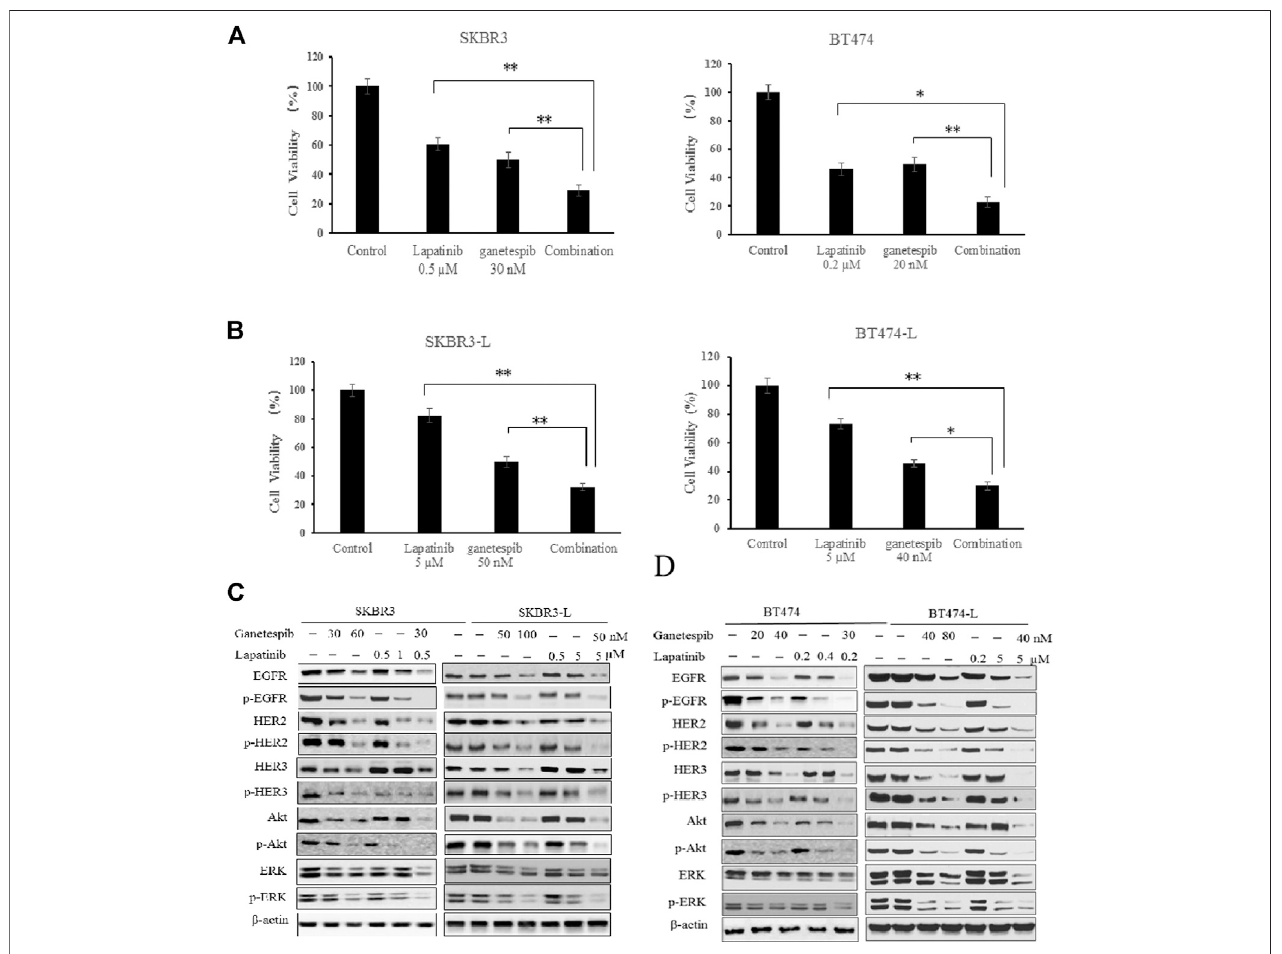
FIGURE 2 | Synergistic effect of ganetespib and lapatinib in lapatinib-sensitive and -resistant breast cancer cell lines. (A) SKBR3, BT474, (B) SKBR3-L, and BT474-L cells were treated with ganetespib, lapatinib or ganetespib plus lapatinib at the indicated optimal combinative concentrations obtained from the Chou-Talalay method (CompuSyn software). Data are presented as means ± SD of three independent experiments, * p < 0.05, ** p < 0.01 vs . combination administration for each cell line by ANOVA. (C) SKBR3, SKBR3-L, (D) BT474, and BT474-L cells were incubated with ganetespib, lapatinib or combination for 24 h. Protein levels were analyzed by western blot for EGFR, HER2, HER3, Akt, ERK and their phosphorylated forms.